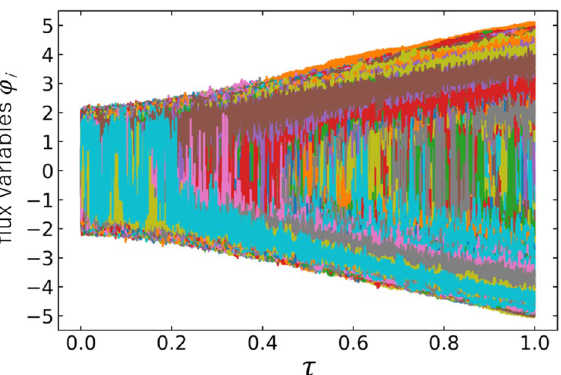
N i = 1 for a typical Ising spin-glass model with